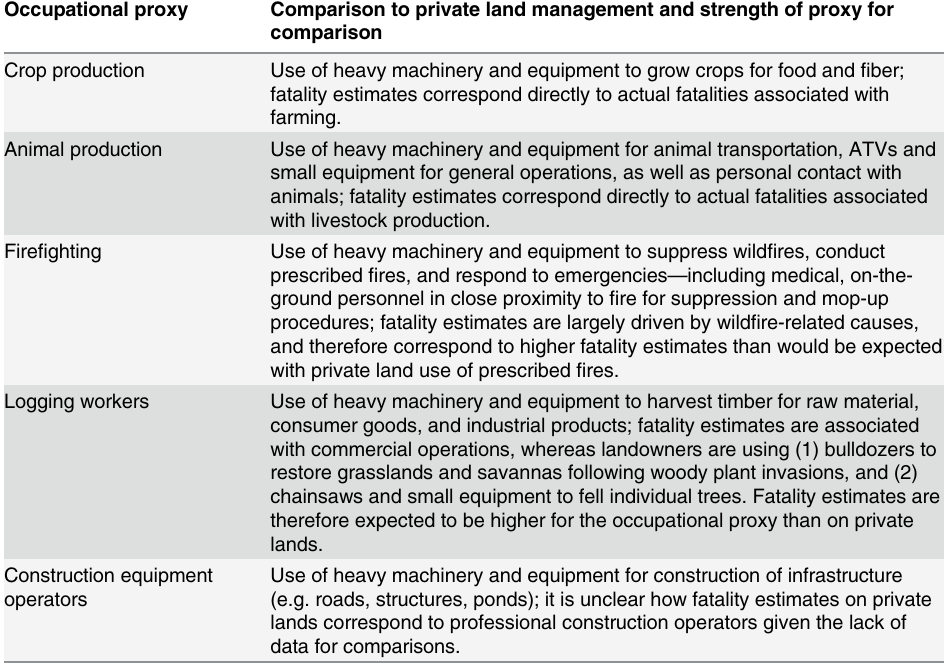
Table 1. Occupational proxies used to establish the relative fatality risk associated with private citizen use of different management techniques, based on data compiled for different occupations from the Census